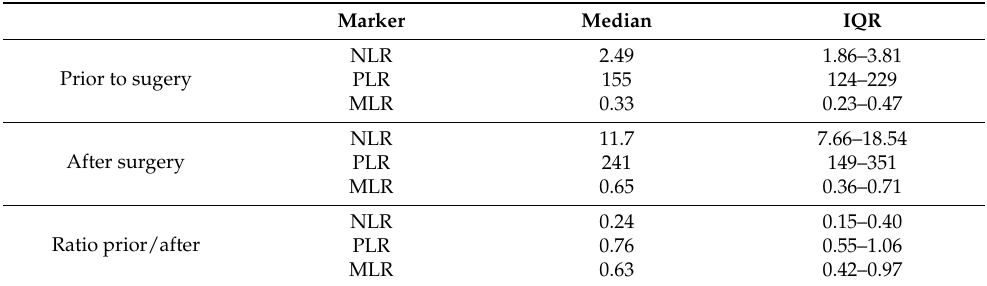
Table 3. Associations between the presence of thrombosis in various compartments and PD-L1 ex- pression on TAICs and TCs.